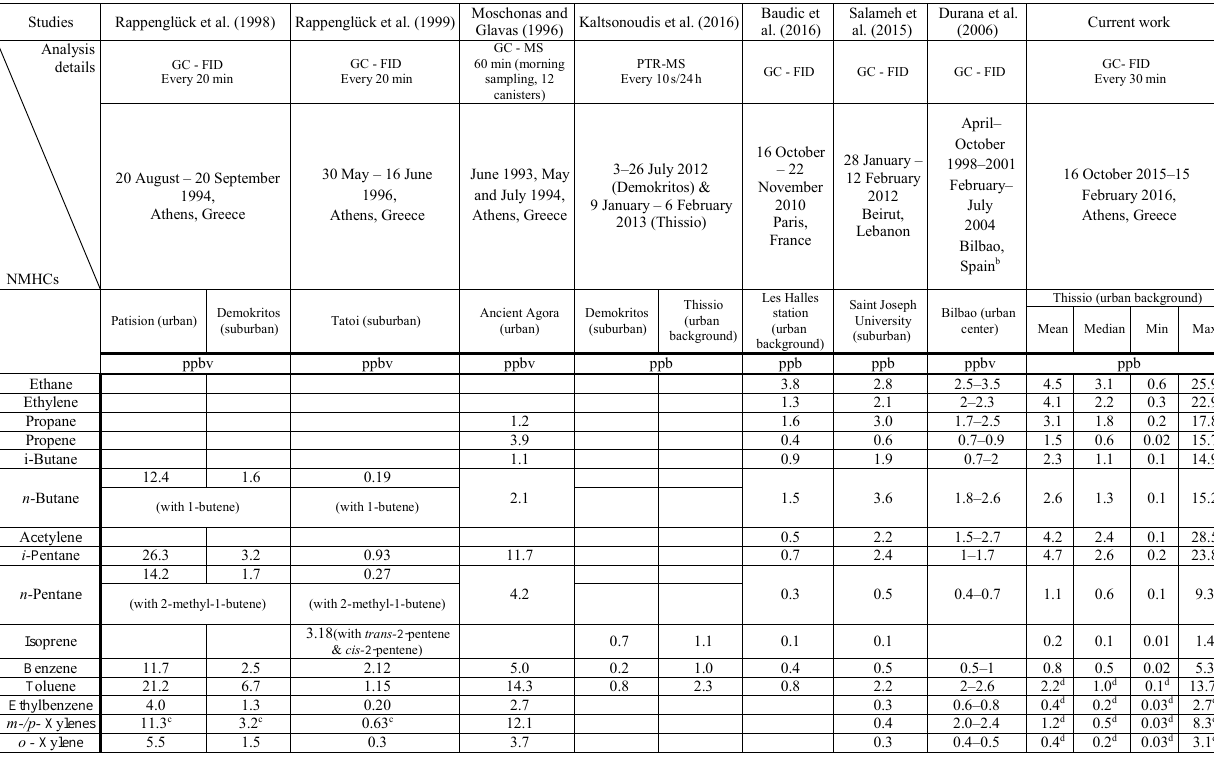
Table 1. Comparison of mean NMHC levels between this study and previously published works in Athens, Greece, and other Mediterranean or European sites. Information regarding the analysis or sampling techniques and data resolution are included when available. The number of measurements a made for each compound determined in the current samples is included below the